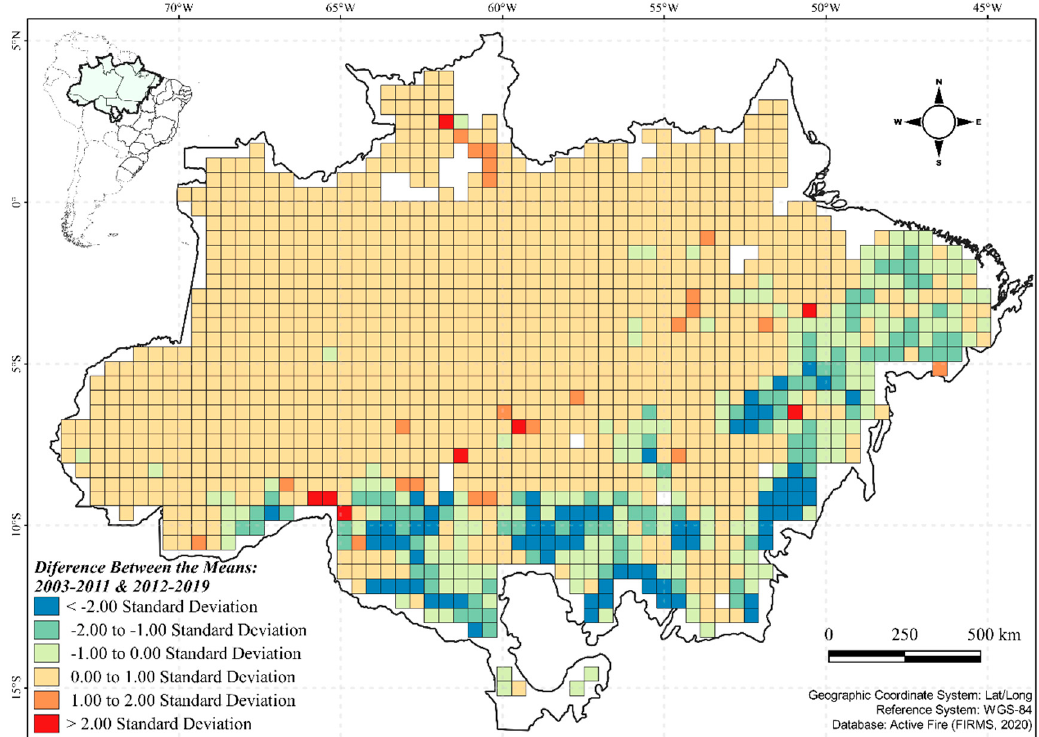
Figure A5. Standard deviation difference between the fire occurrence in the two analysed periods. We made this calculation based on the mean of the second period (2012–2019) minus the mean of the first period (2003–2011).